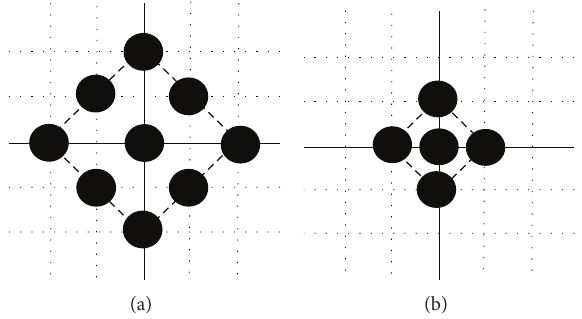
Figure 4: (a) Large diamond search pattern (LDSP). (b) Small diamond search pattern